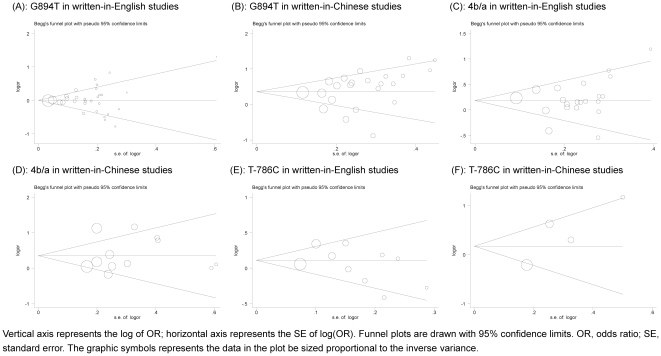
Funnel plots of allele comparisons for eNOS three polymorphisms upon stratification by published language.Vertical axis represents the log of OR; horizontal axis represents the SE of log(OR). Funnel plots are drawn with 95% confidence limits. OR, odds ratio; SE, standard error. The graphic symbols represents the data in the plot be sized proportional to the inverse variance.